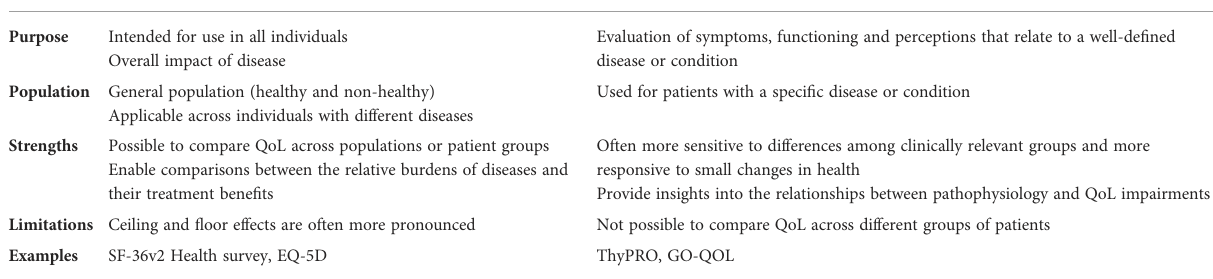
TABLE 1 There are two broad categories of PROs, generic and disease-speci fi c. Generic